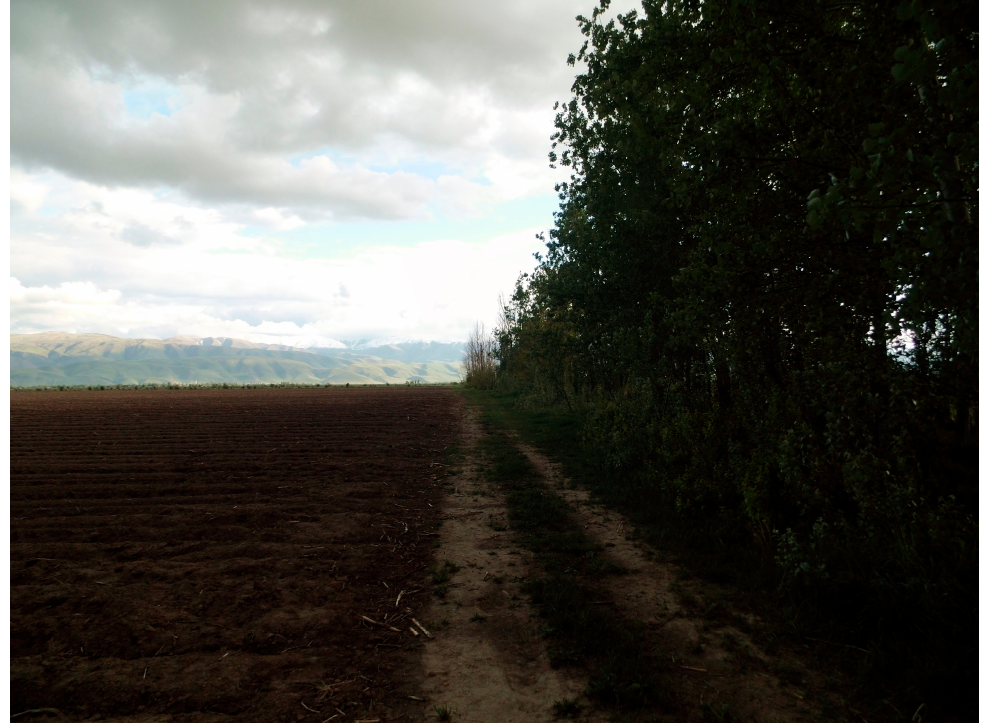
Figure 2. Shelterbelt in Karasay Batyr, where sap flow was measured during 2016, with neighboring potato field (photo Niels Thevs, April 2016).